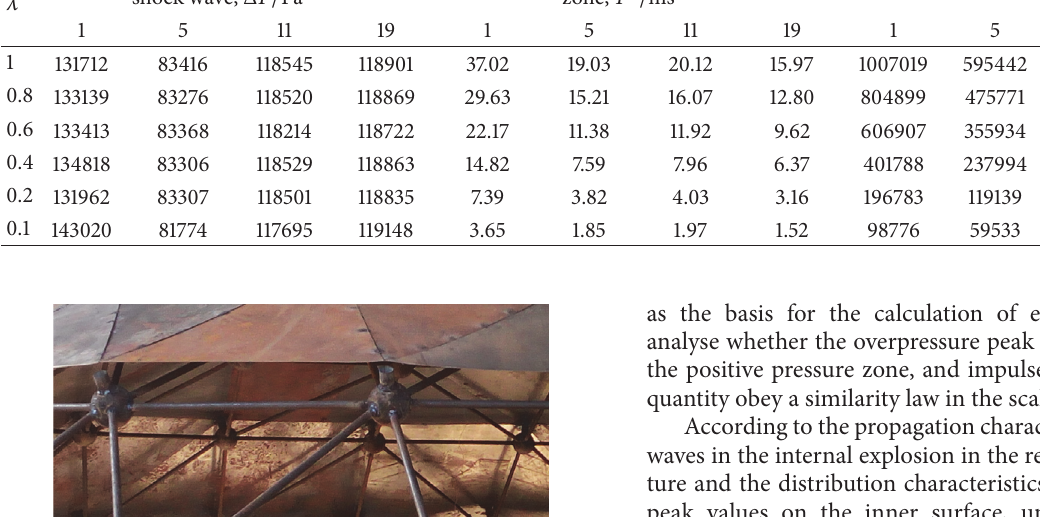
Table 4: Peak overpressure values at each unit position, action time of the positive pressure zone, and impulse. Overpressure peak values of the 𝜆 shock wave, Δ𝑃/ Pa